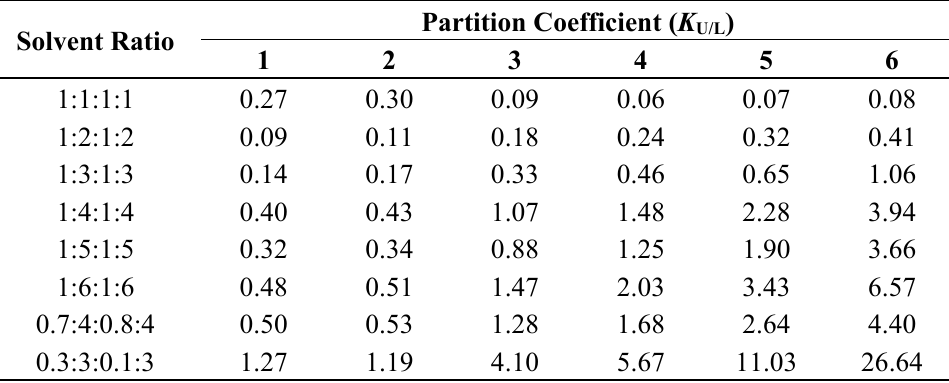
Table 1. K values of compounds 1 – 6 from P. guajava leaves in two-phase solvent systems ( n -hexane–ethyl acetate–methanol–water) for HSCCC separation.